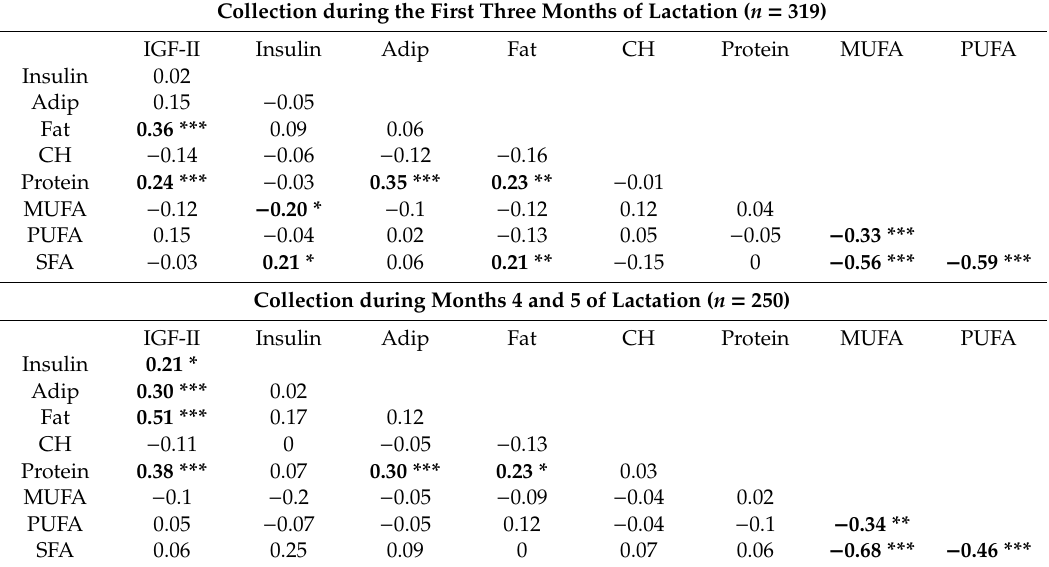
Table 6. Pearson correlations between the concentrations of macronutrients, hormones, and FA groups (weight%) stratified according to sample collection